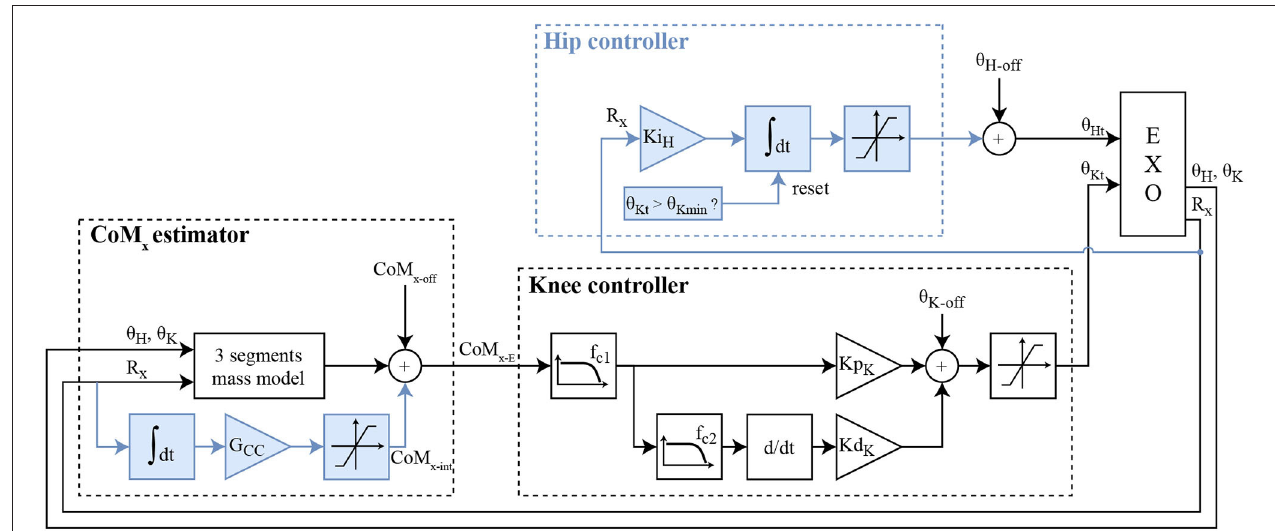
FIGURE 2 | Block diagram of the two controllers. BKC is made of the CoM x estimator and the knee controller (white blocks). EKC is made of the improved CoM x estimator, the knee controller, and the hip controller (all the blocks). The blue boxes are thus the additions of EKC. CoM x − E corresponds to CoM x − E1 for BKC, and CoM x − E2 for EKC. CoM x − off represents the offset added to the estimated projection of the CoM in the sagittal axis. θ K − off and θ H − off are, respectively, the baseline offsets of the knee and the hip angles.